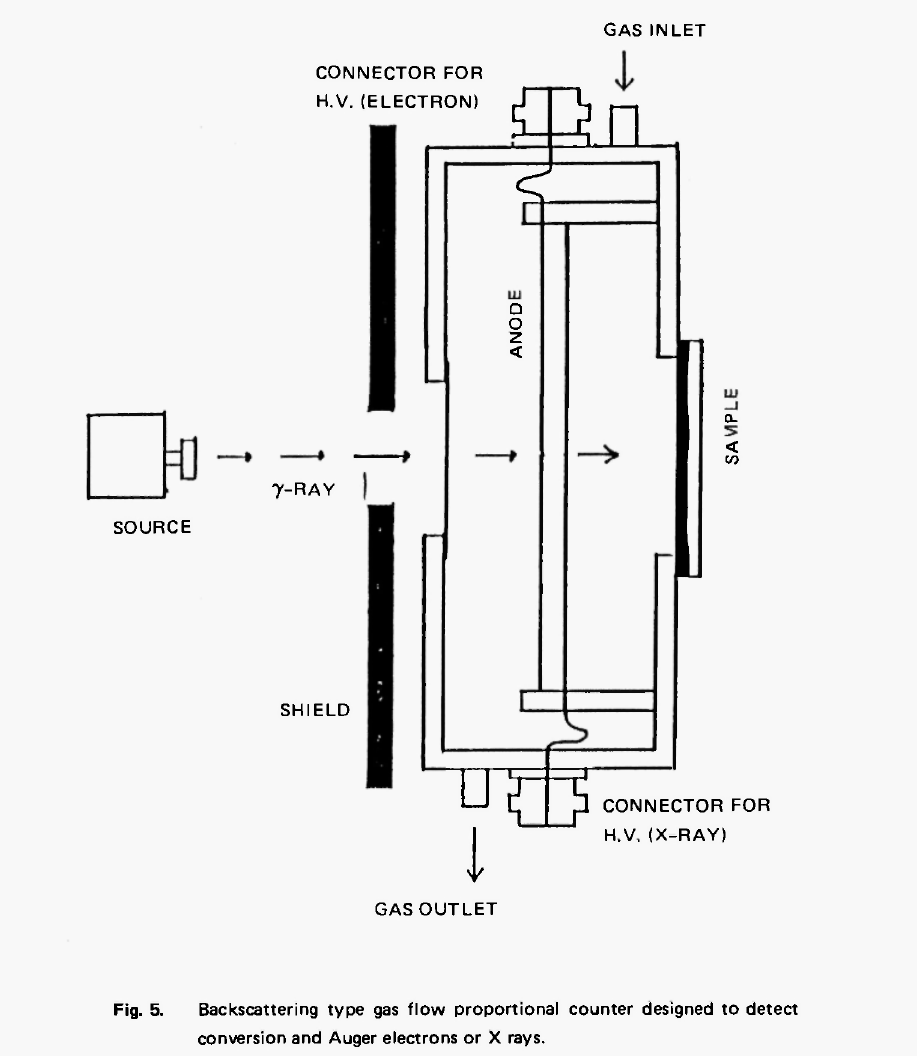
Backscattering type gas flow proportional counter designed to detect conversion and Auger electrons or X rays.